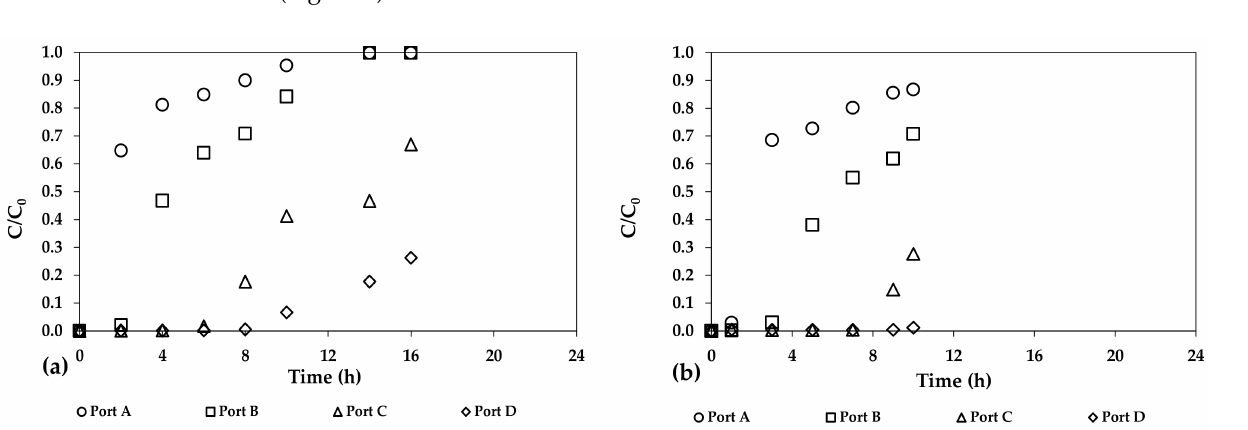
Figure 2. Breakthrough curves for Test 1 ( a ) and Test 2 ( b ) with respective biochar–sand volume ratios of 7:100 and